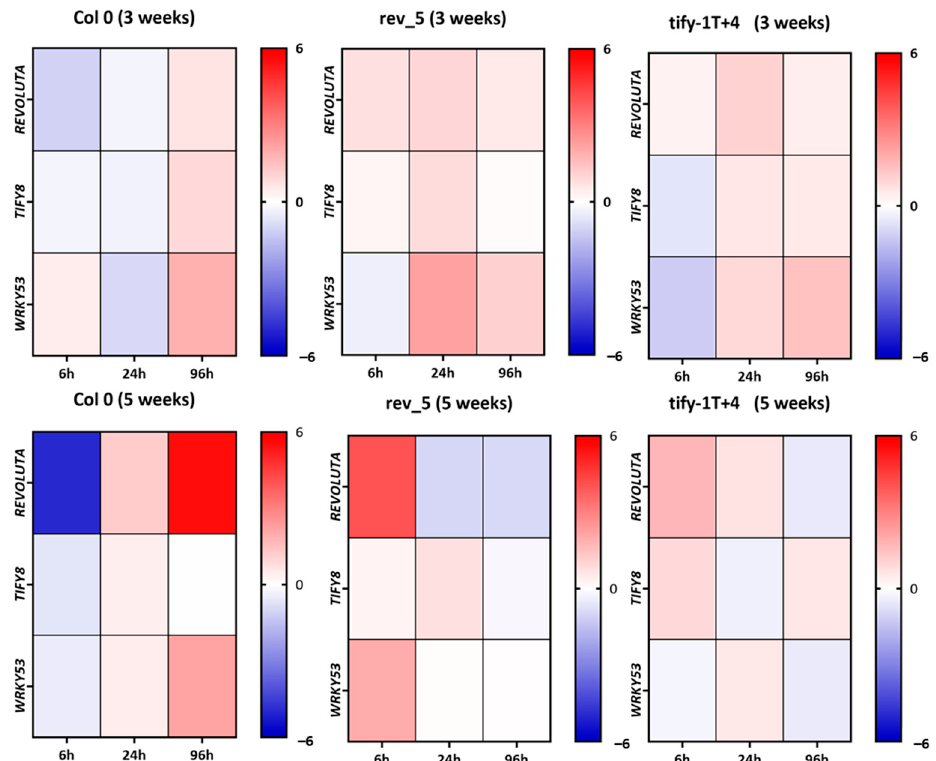
Figure 7. Heat map of the gene expression measured by qRT-PCR of REV , TIFY8, and WRKY53 in Col-0, rev5, and tify8 mutant plants for 3-week-old and 5-week-old plants 6 h, 24 h, and 96 h after JA treatment. Expression is shown as log2-fold changes relative to the respective MOCK treatments; blue color indicates repression, whereas red color indicates induction.